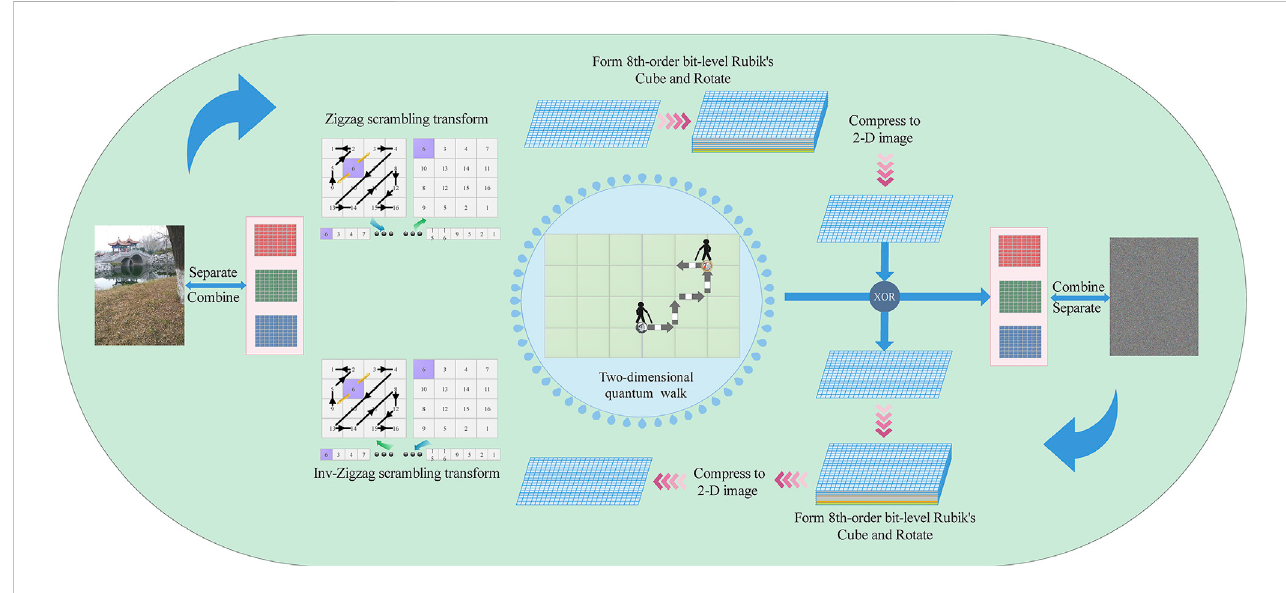
FIGURE 3 Encryption algorithm under a 2-D quantum walk.